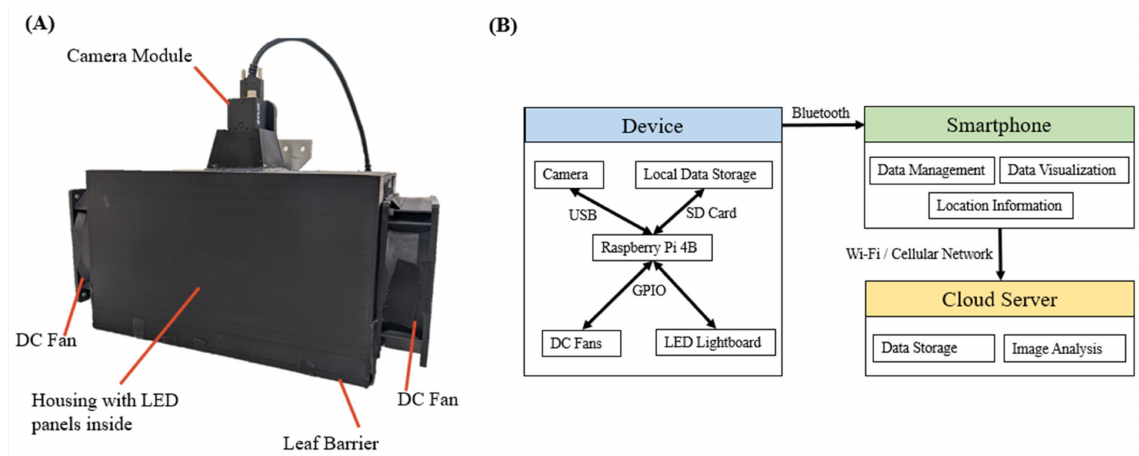
Figure 2. ( A ) Device Assembly. ( B ) Command and data flow between each